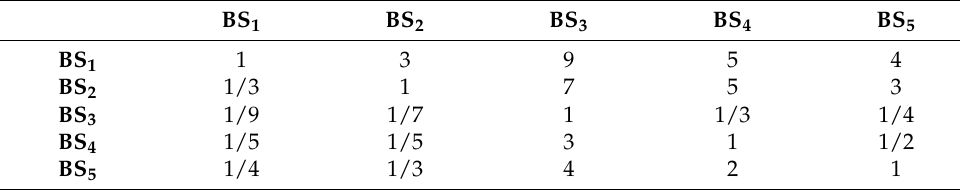
Table A10. The pairwise comparison matrix User _ C 3 .